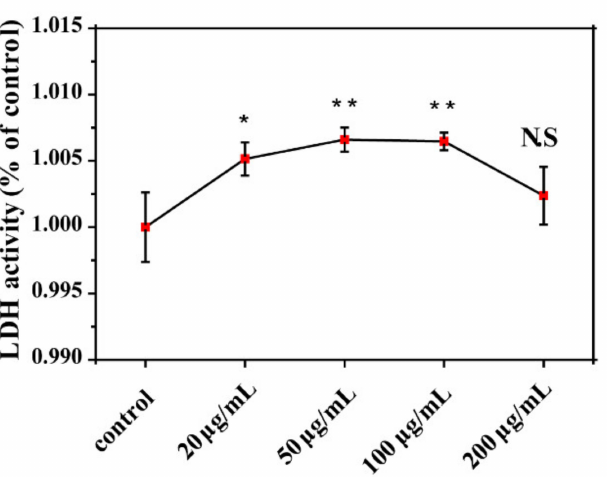
Figure 7. LDH content of E. coli exposed to GORs in different concentrations for 24 h (* p < 0.05, ** p <